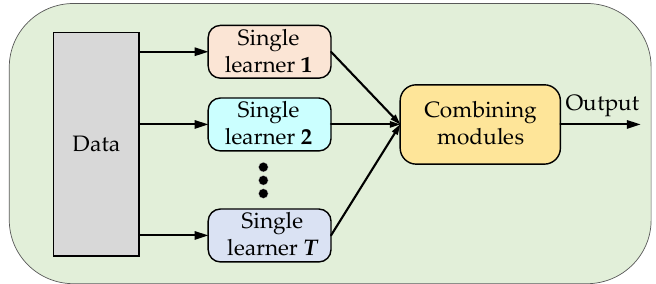
Figure 2. The usual structure of ensemble learning.